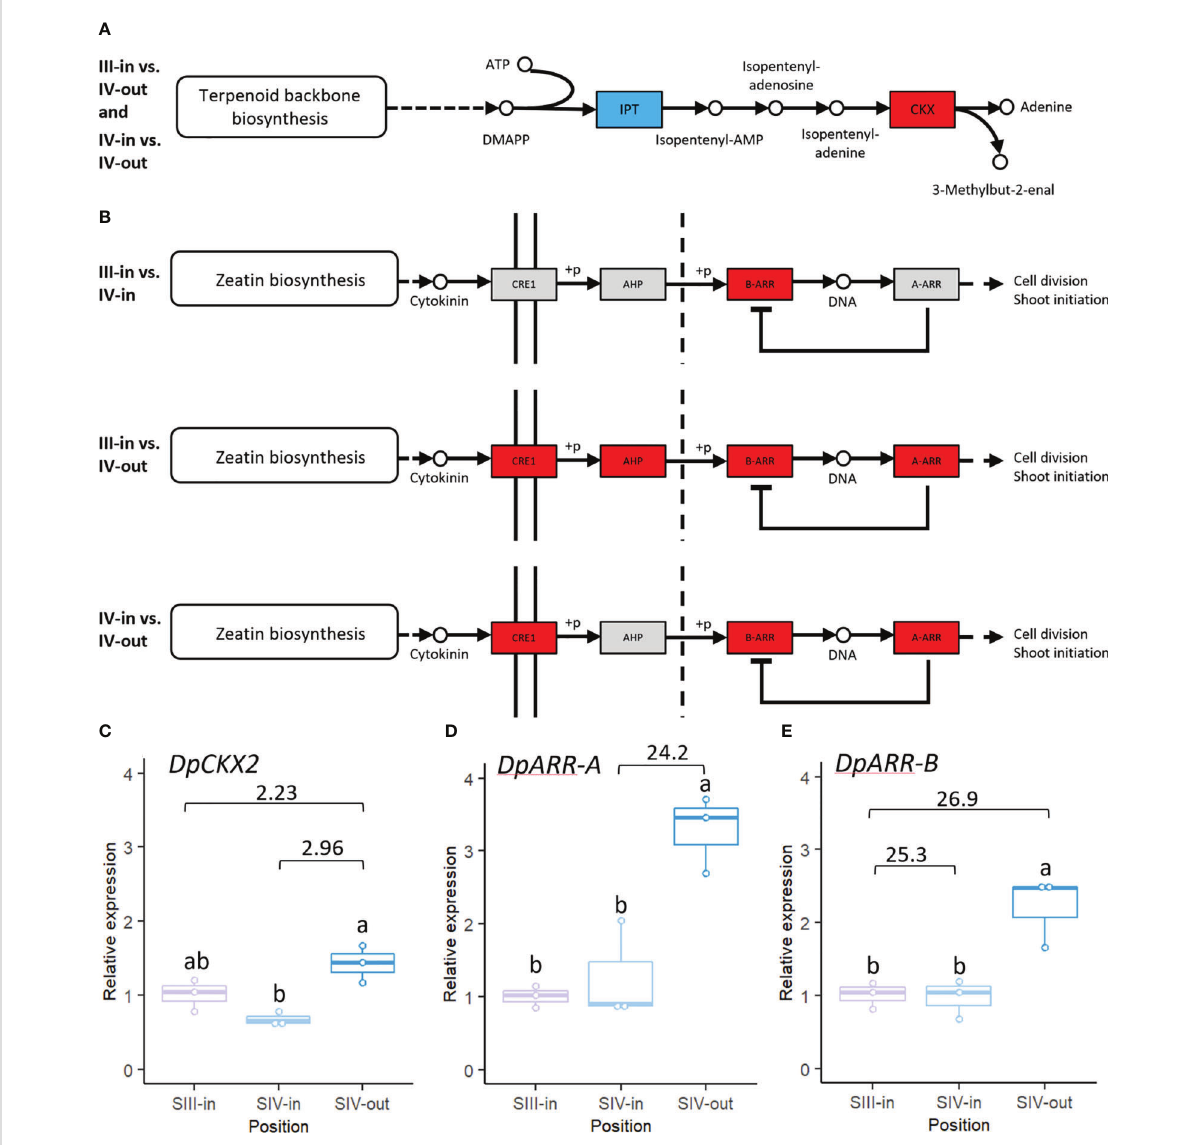
FIGURE 8 Transcriptomic changes in expression of dahlia fl oret genes associated with cytokinin (A) biosynthesis (B) signal transduction pathway in comparisons between fl orets from: III-in vs. IV-in, III-in vs. IV-out and IV-in vs. IV-out (from KEGG, Kanehisa & Goto, 2000). Grey indicates no signi fi cant change in gene expression, red indicates signi fi cantly upregulated and blue indicates signi fi cantly downregulated ( p < 0.05). There were no signi fi cant changes in expression of cytokinin biosynthesis related genes in III-in vs. IV-in fl orets. (C – E) RT-qPCR analysis of (C) DpCKX2 (D) DpARR-A (E) DpARR-B , n=3, different letters indicate signi fi cant differences p < 0.05, based on a 2-way ANOVA followed